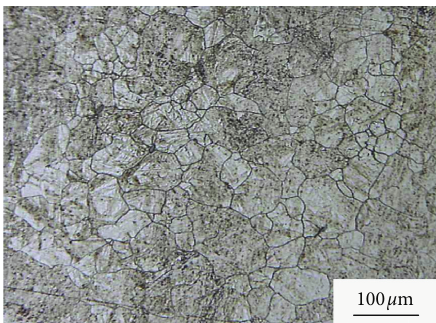
Figure 1: The initial microstructure of as-cast 42CrMo ring blank [18].